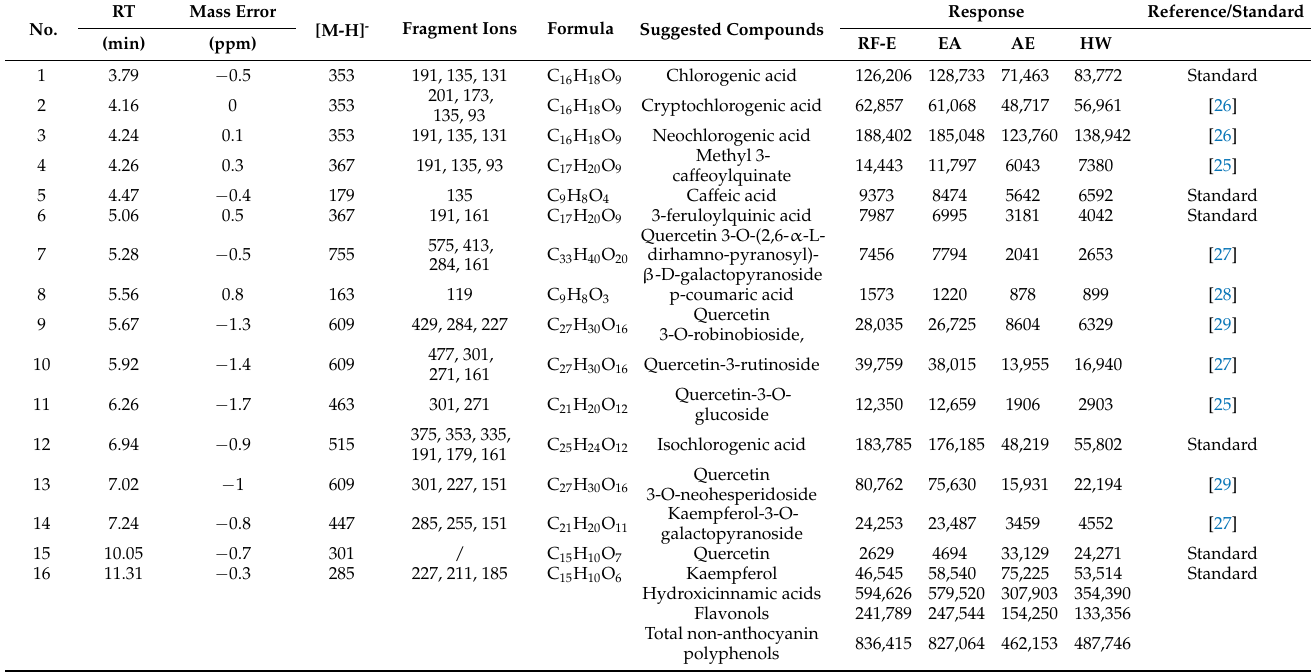
Table 1. Non-anthocyanin polyphenols identified in A. trifoliata flowers extracts by UPLC-PDA-TOF-